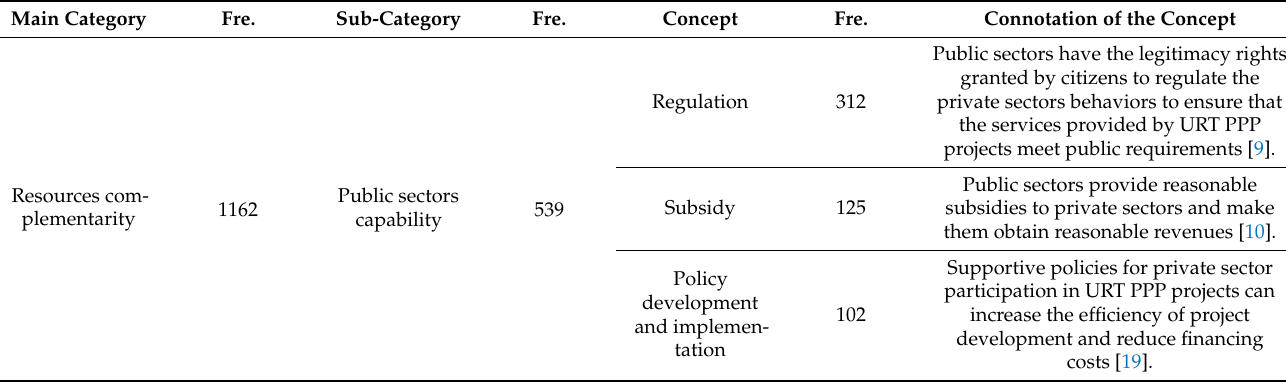
Table 3. Categorization of factors influencing the value creation of the URT PPP